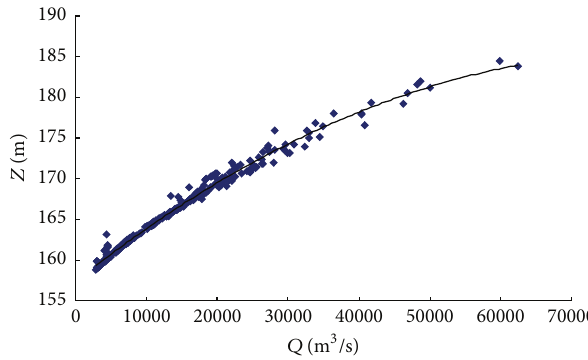
Figure 2: Discharge and water level relationship